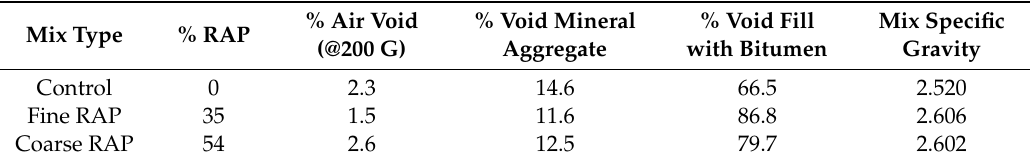
Figure 5. Coring graphical illustration.